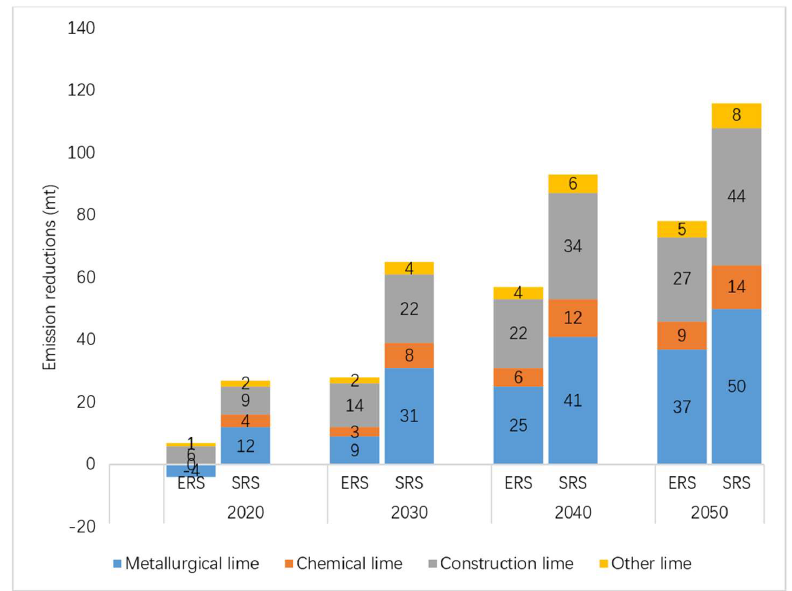
Figure 6. Emission reductions for different lime products in two emission reduction scenarios based on 2012 emission levels.